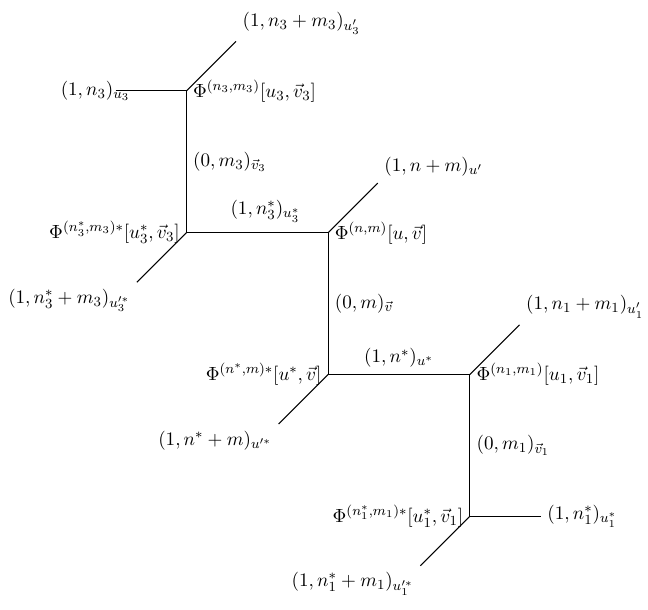
Figure 11 . Representation web of the A 3